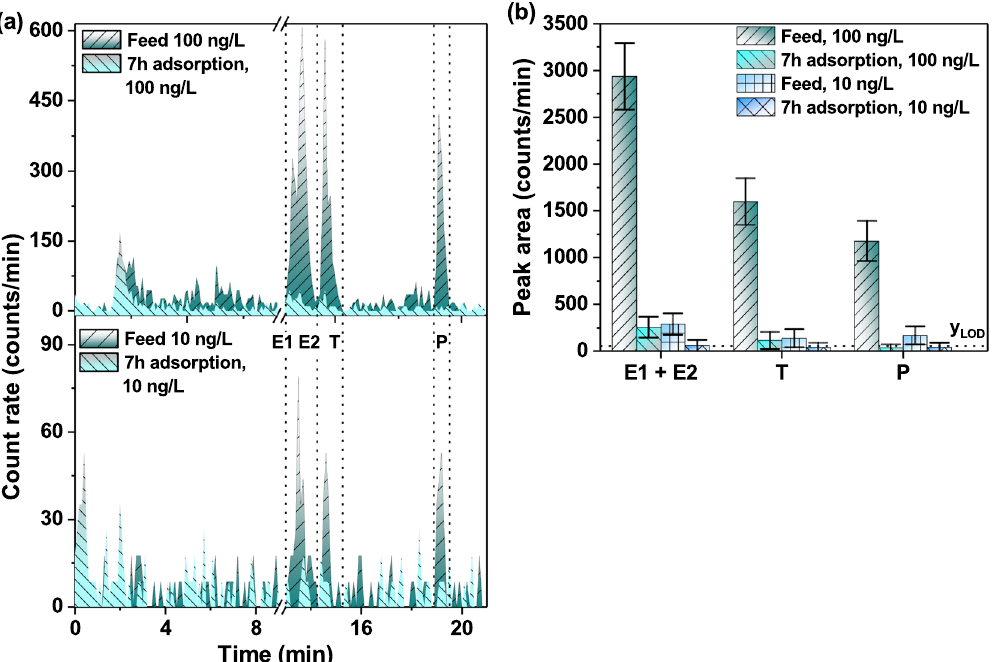
Figure 5. Adsorption experiments with the mixtures of E1, E2, T, and P (100 and 10 ng/L each). ( a ) UHPLC- FSA radiochromatograms, ( b ) the change of obtained peak areas for analytes after 7 h of adsorption experiment. The error bar was estimated via error propagation approach as presented in Supplementary Information.